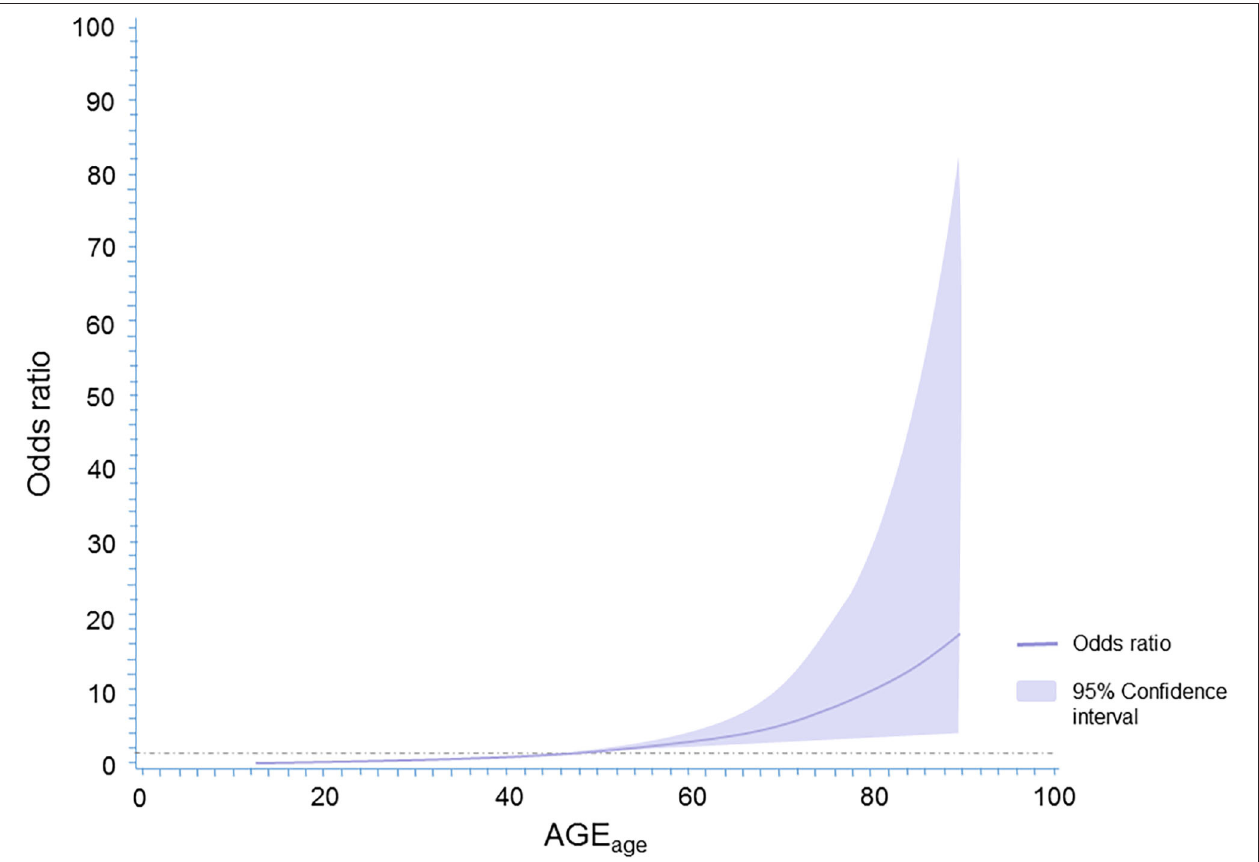
FIGURE 2 | The spline association between AGE age and LEAD in patients with type 2 diabetes mellitus. Adjustments were made for sex, diabetes duration, BMI, blood pressure, lipid panels, HbA 1c , CRP, family history of diabetes, smoking status, antidiabetic therapy, antihypertensive medication, lipid-lowering medication, and aspirin